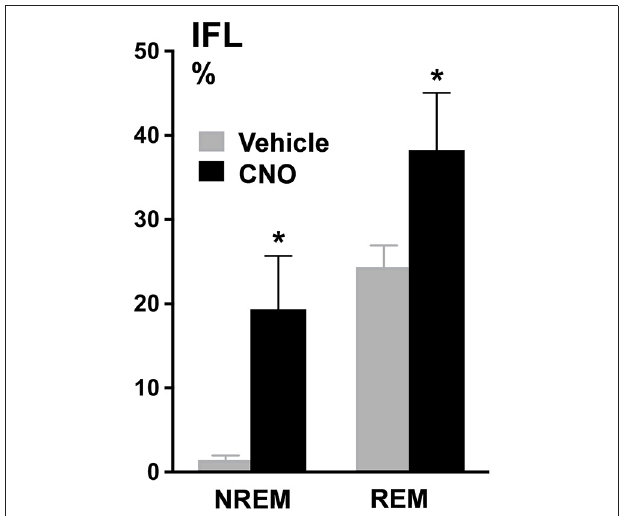
FIGURE 6 | Percentage of flow limited breaths in both NREM sleep (1.9% ± 1.3% baseline vs. 14.2% ± 3.4% CNO, p < 0.05) and REM sleep (22.3% ± 4.1% baseline vs. 30.9% ± 4.6% CNO, p < 0.05). * p < 0.05.